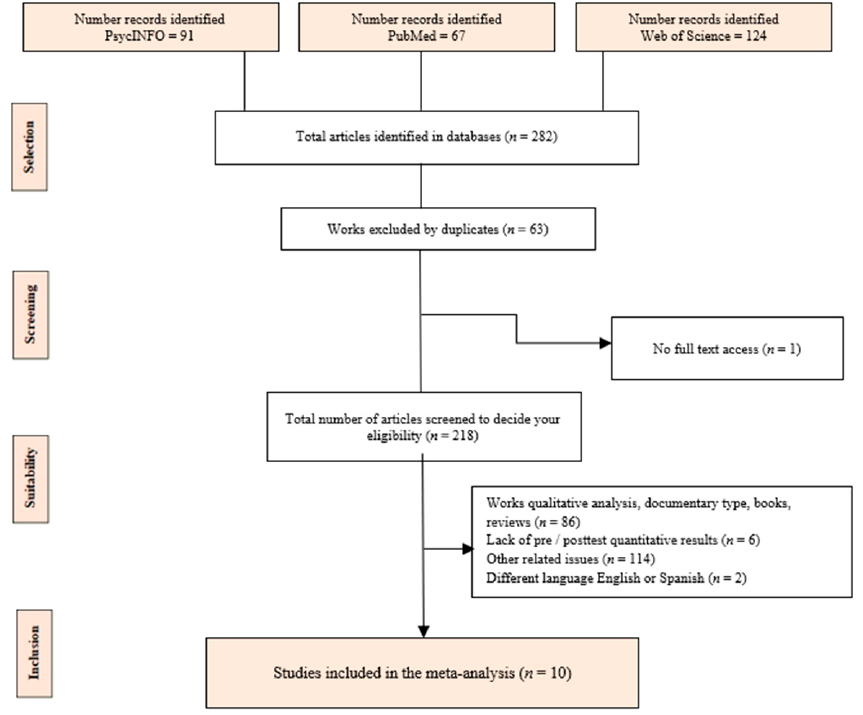
Figure 1. Flow diagram showing article selection steps. Table 1. Studies dealing with the relationship between mindfulness and